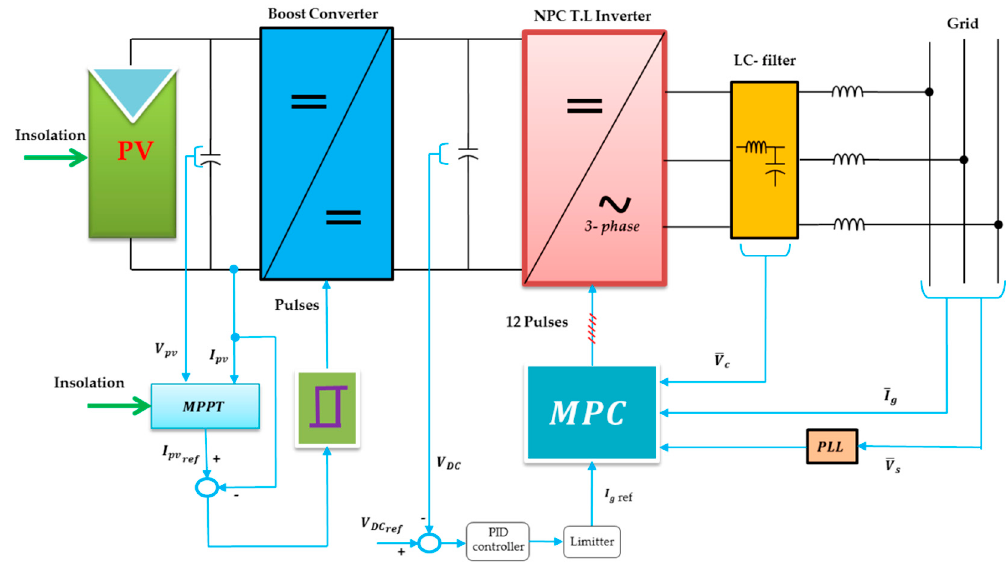
Figure 1. The proposed photovoltaic (PV)-powered 3-level transformerless inverter connected to the grid and its controllers.